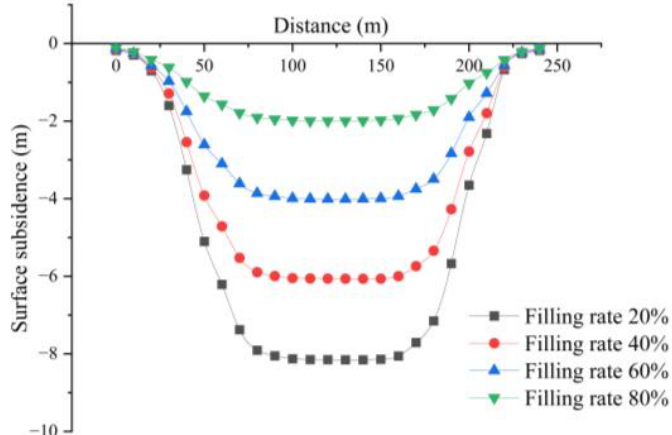
Figure 6. Upper boundary subsidence curves of the model at different filling rates.